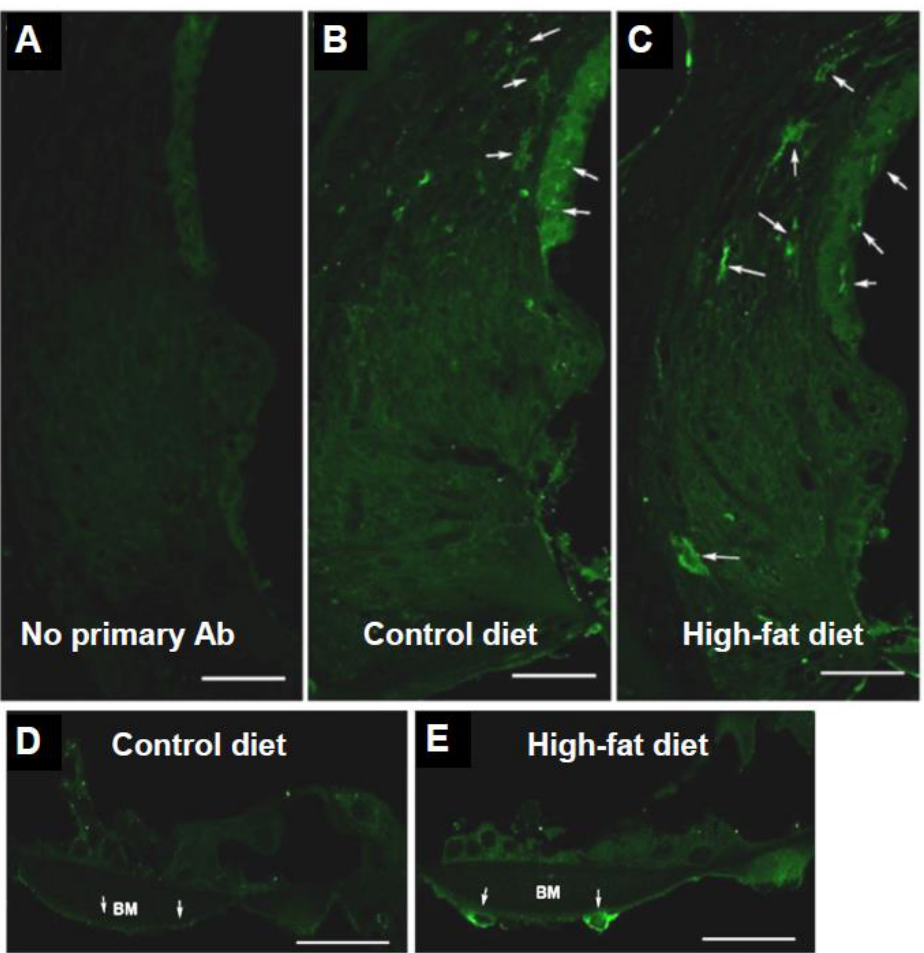
Figure 3. TLR2 immunofluorescence in the mouse cochlea. ( A ) control section stained with the normal IgG-Alexa 488 conjugate; ( B , C ) TLR2 immunofluorescence in the lateral wall of the cochlea in mice on a high-fat or control diet; ( E ) TLR2 immunofluorescence was observed in the mesothelial cells (arrows) under the basilar membrane (BM) in mice on a high-fat diet (HFD), but not in mice on a control diet ( D ). Scale bars, 50 μm ( A – C ), 35 μm ( D , E ).